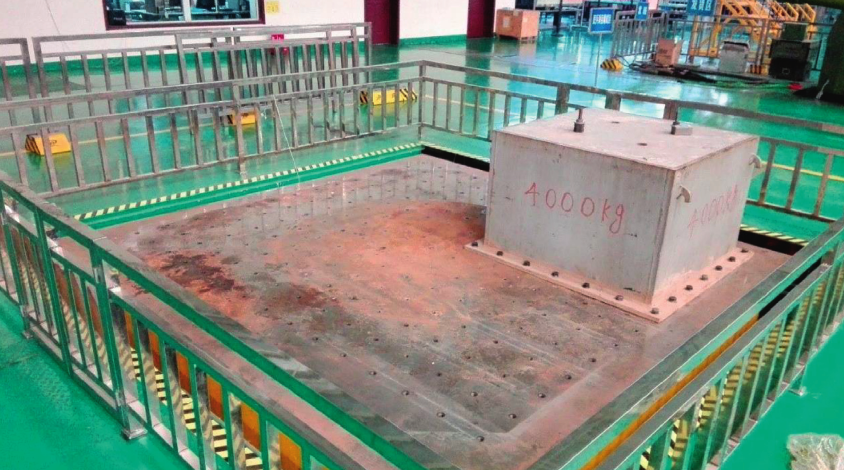
Figure 8: Multiaxis hydraulic servo shaking table with eccentric load.